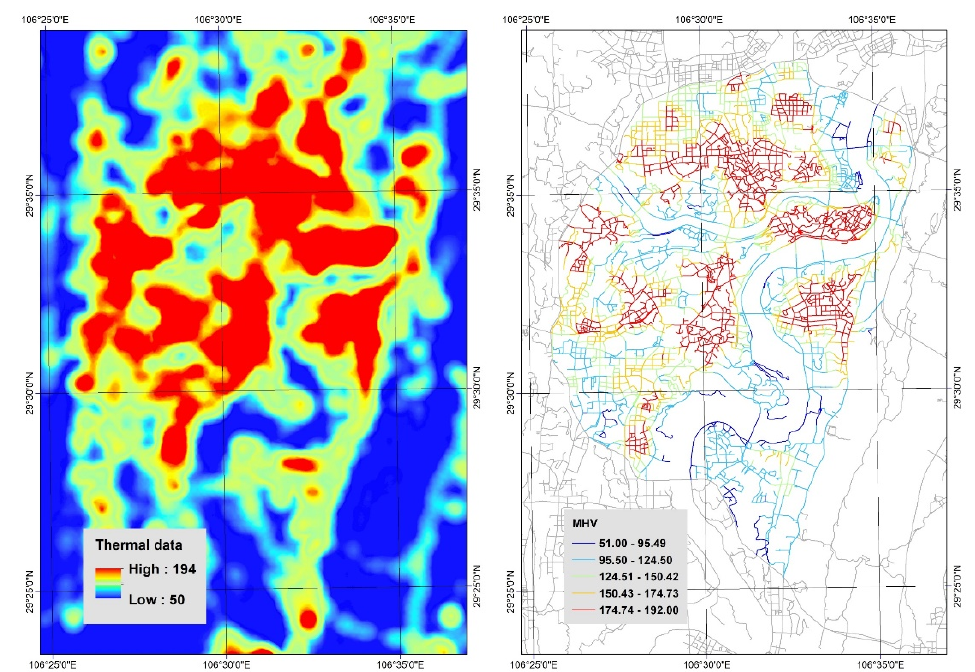
Figure 5. Comparison of heat map data before and after processing ( left : heat map data before processing; right : heat map data after processing).